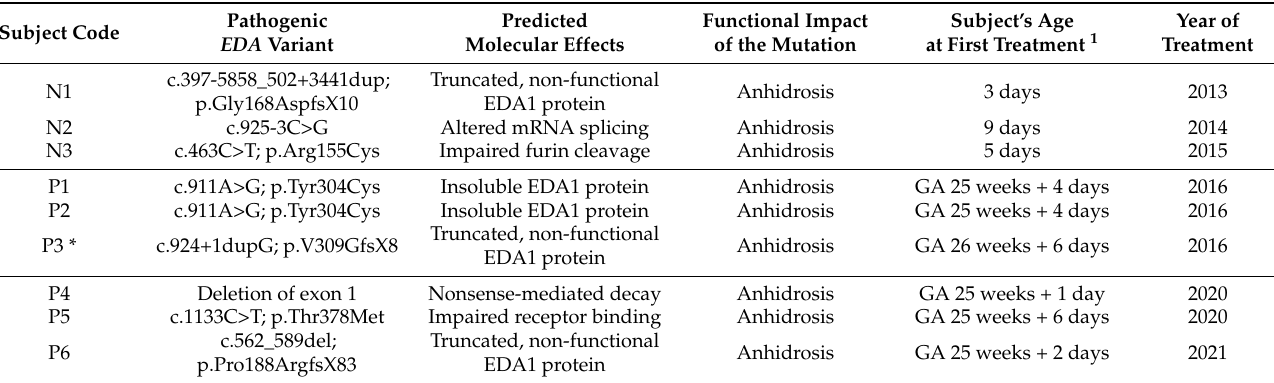
Table 1. Molecular and clinical characteristics of the study